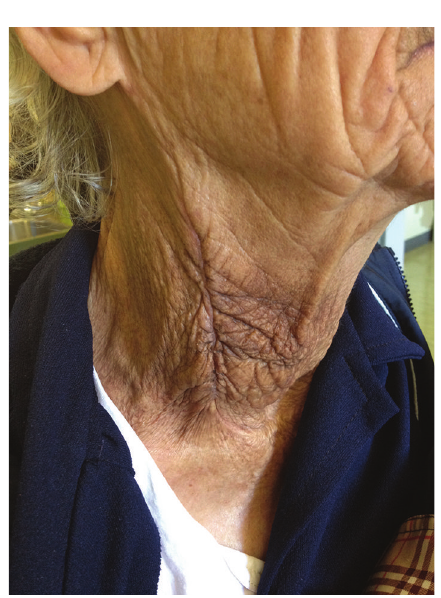
Figure 3: Our patient 6 months